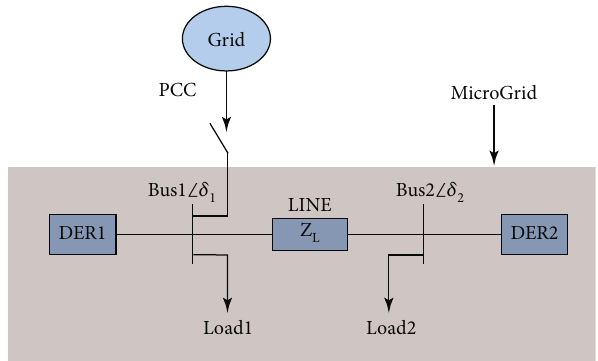
Figure 1: Islanded Microgrid Parallel